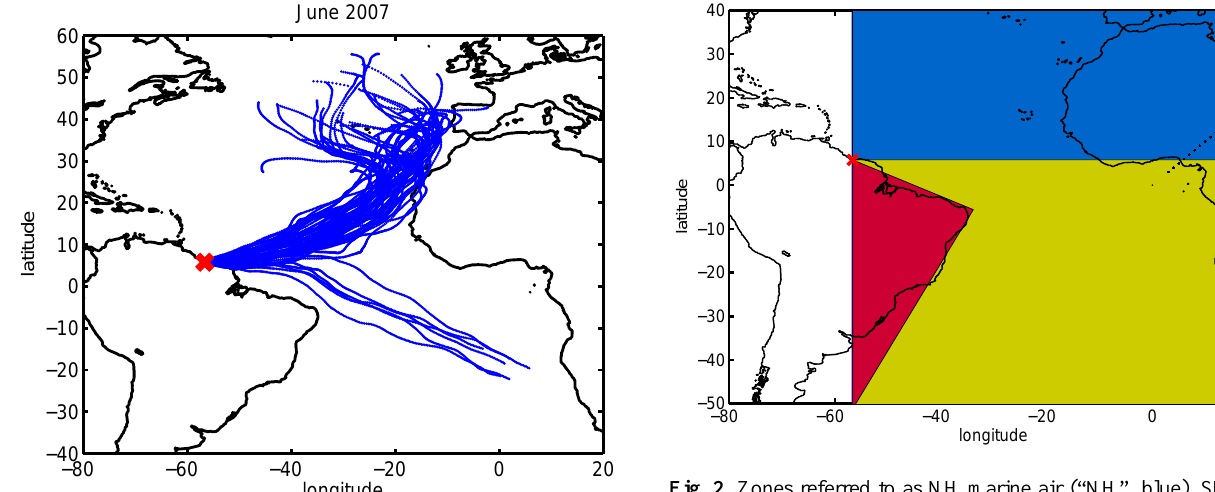
Fig. 2. Zones referred to as NH marine air (“NH”, blue), SH marine air (“SH”, yellow) and SH continental air (“Land”, red). No trajectories passed through the white section in the 10 days before reaching Nieuw Nickerie. The red cross marks the measurement location.